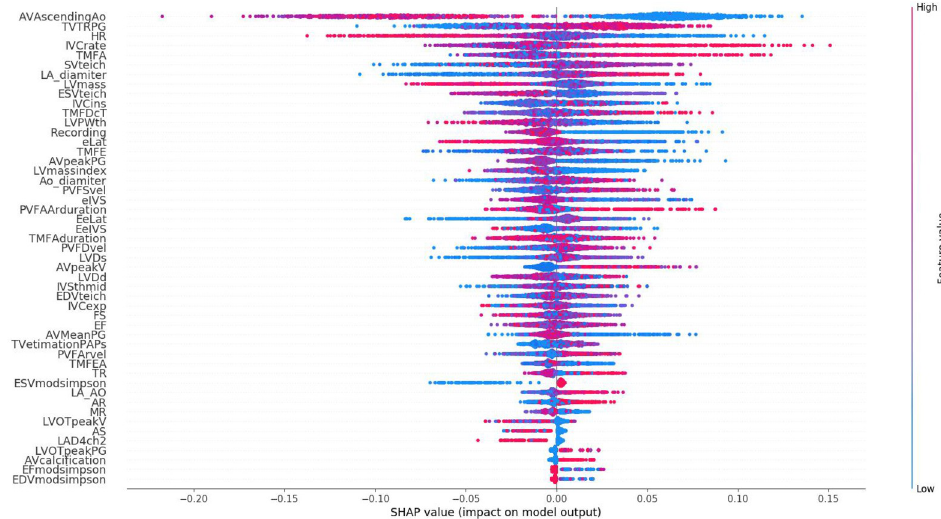
Fig 2. Reduction of dimensionality by the SHapley Additive exPlanations (SHAP) method. The number of features used for training was reduced from 95 to 49. Each point in the figure is a Shapley value of a feature. The x-axis shows the Shapley value, and the y-axis shows the feature importance. Each value of each variable is colored by value, and its position on the x-axis is shown as a single dot indicating the impact that value of the variable had on the model prediction in logit space. Variables with a wide spread have a greater impact on model predictions. The colors indicate whether low or high values of each variable affect risk and in which direction. AVAscendingAo, ascending aorta diameter; TVTRPG, tricuspid regurgitation pressure gradient; HR, heart rate; IVCrate, inferior vena cava inspiratory/ expiratory rate; TMFA, transmitral flow A wave; SVteich, stroke volume (Teichholz); LA_diamiter, left atrium